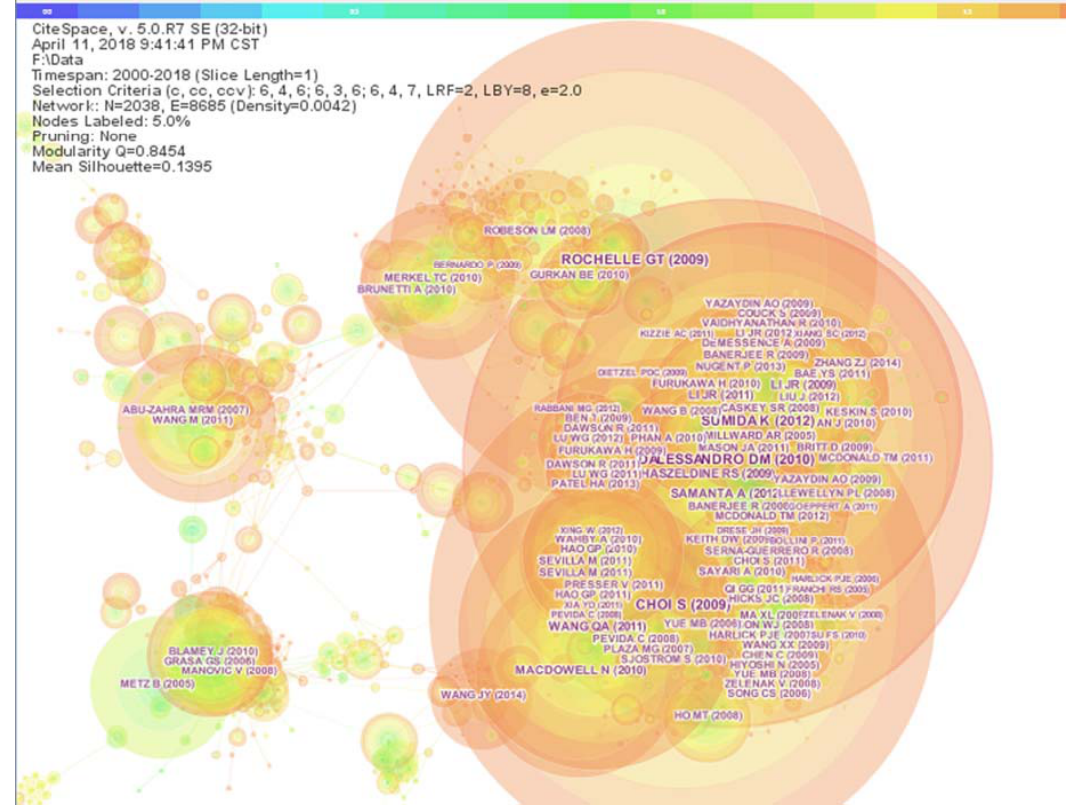
Figure 4. Co ‐ citation literature network of CCS research area. Figure 4. Co-citation literature network of CCS research